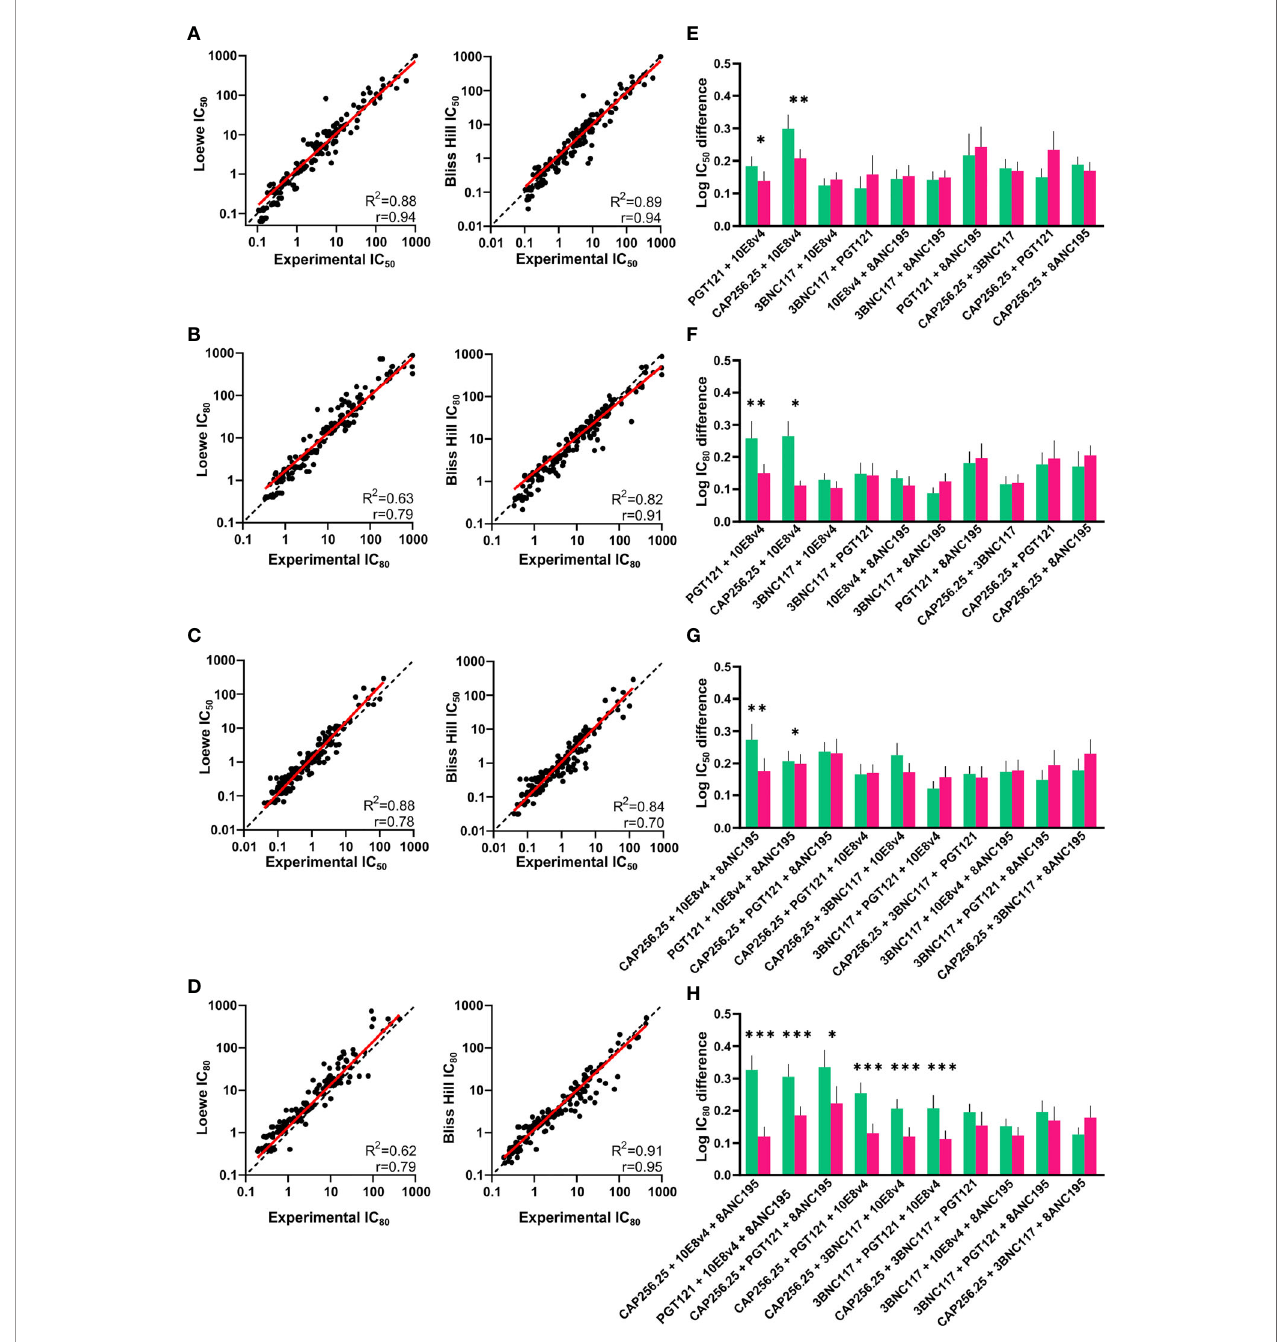
FIGURE 3 | Comparison of experimental and predicted combinations of dual and triple scFv. (A, B) IC 50 and IC 80 titers of dual antibody combinations plotted against the predicted IC 50 and IC 80 titers according to the Loewe Additive (left) and Bliss-Hill Independence (right) models. (C, D) Predicted IC 50 and IC 80 titers of triple combinations versus the experimental IC 50 and IC 80 titers. Values where both or all titers of single scFv >30 m g/mL are excluded. (E, F) Comparison of the absolute Log(IC 50 ) and Log(IC 80 ) difference between the experimental titers and predicted titers according to the Loewe Additive (green) and Bliss-Hill independence (purple) for the dual combinations. (G, H) Comparison of the absolute Log(IC 50 ) and Log(IC 80 ) difference between the experimental titers and predicted titers according to the Loewe Additive (green) and Bliss-Hill independence (purple) models for the triple combinations. For (A, B, E, F) , a nonlinear robust regression log-log line (red) and an equity line (black dotted) as well as r, R2, are shown and p<0.0001. For (C, D, G, H) , mean values are given with a standard error of the mean. A paired, Wilcoxon t-test was performed on each pair with signi fi cant p values above the graphs (p < 0.05 = * p < 0.01 = ** p < 0.001=